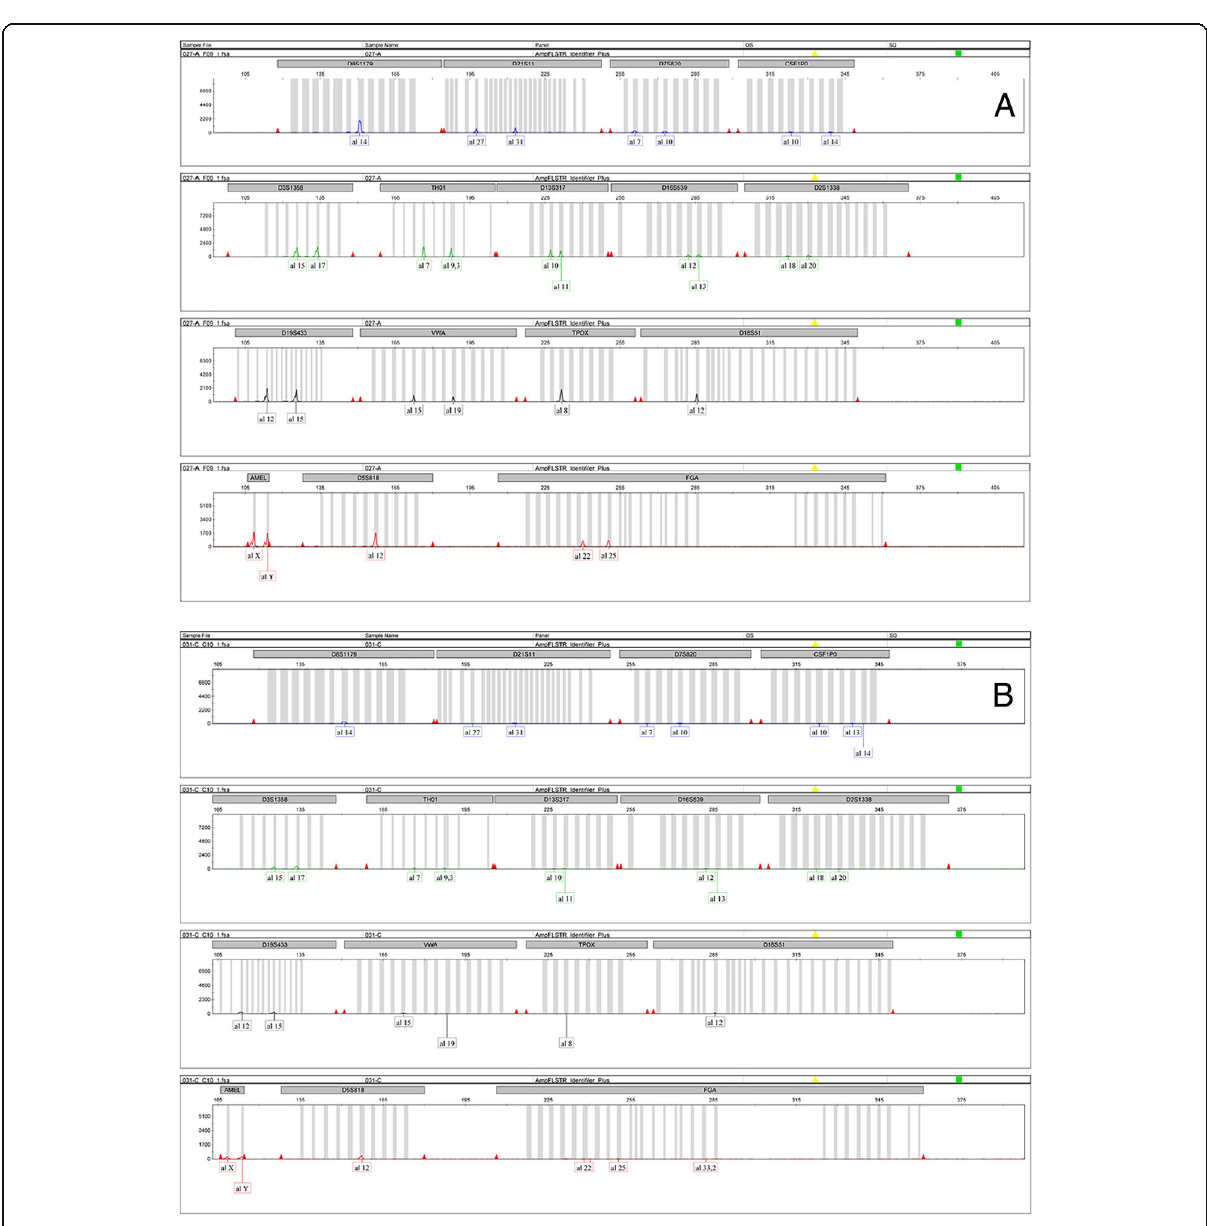
Fig. 3 The reference profile of the victim ( a ) was compared with the profile obtained with adhesive tape ( b